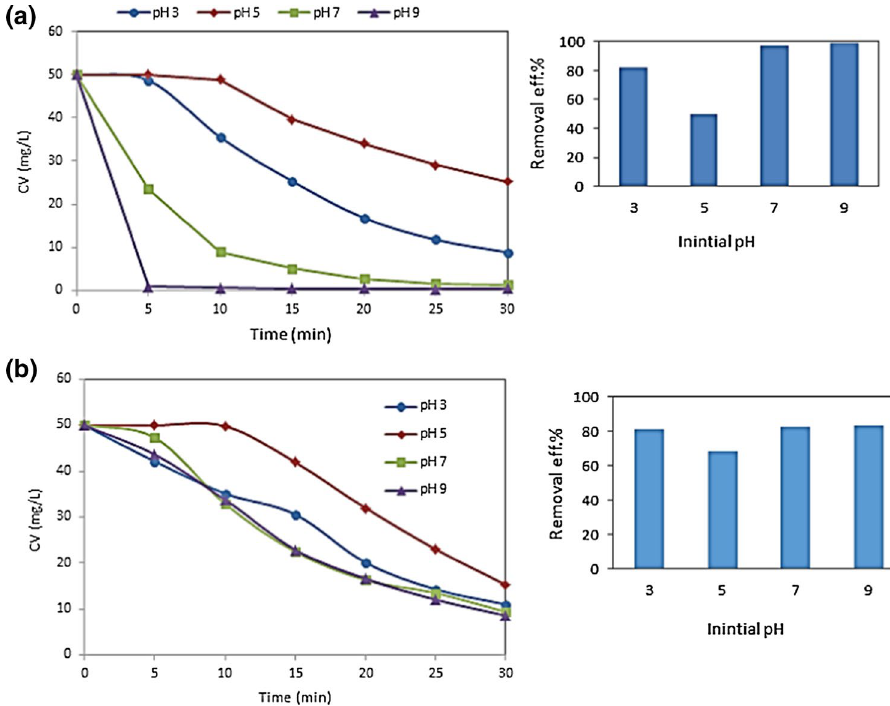
Fig. 3 Effect of pH on peroxone a and e-peroxone/H2O2 (b) efficiency [condition: reactor volume 500 cc and 70 rpm, applied current 0.1 A, NaCl 100 mg/L, initial CV concentra- tion 50 mg/L, ozone 2 mg/L. min and H 2 O 2 15